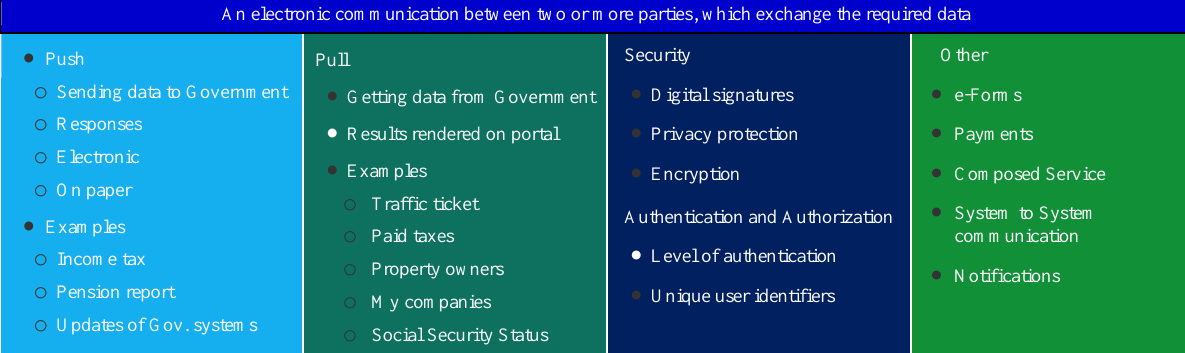
Table 1. Presentation of the communication of the parties for the exchange of the requested